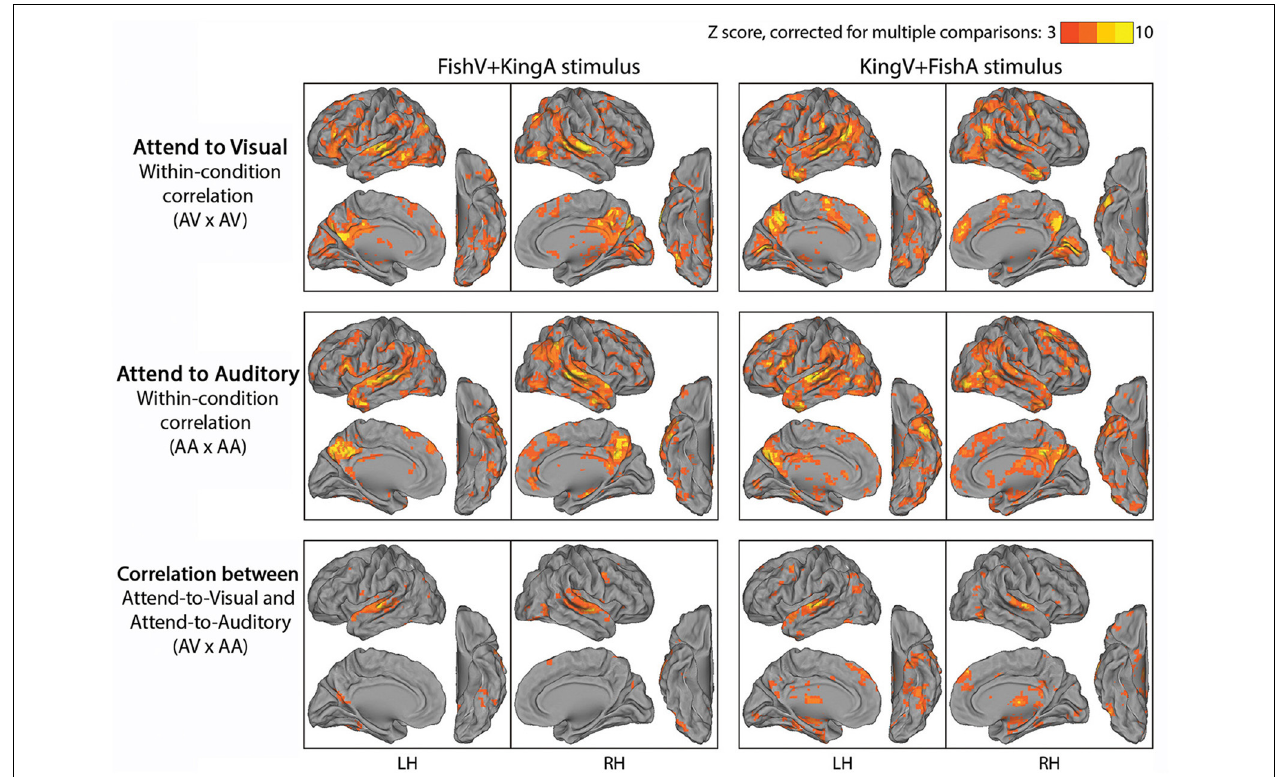
FIGURE 3 | Results of Experiment 2. In the top and middle rows, fMRI time series were correlated across subjects under a specific task condition with identical physical stimulus and attentional focus (attending the visual stream in the top row, AV × AV; attending the auditory stream in the middle row, AA × AA). In the bottom row, fMRI time series were correlated across subjects